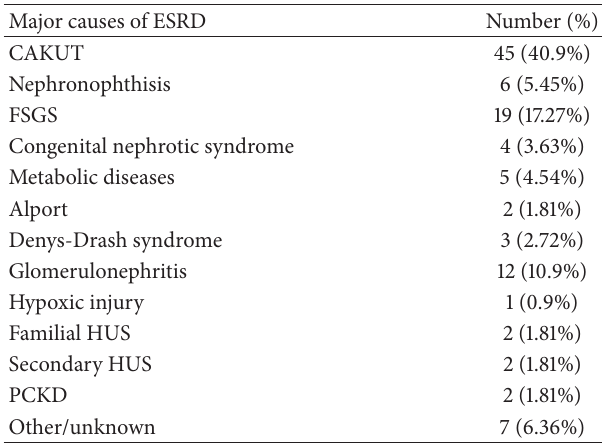
Table 1: Causes of ESRD leading to need for